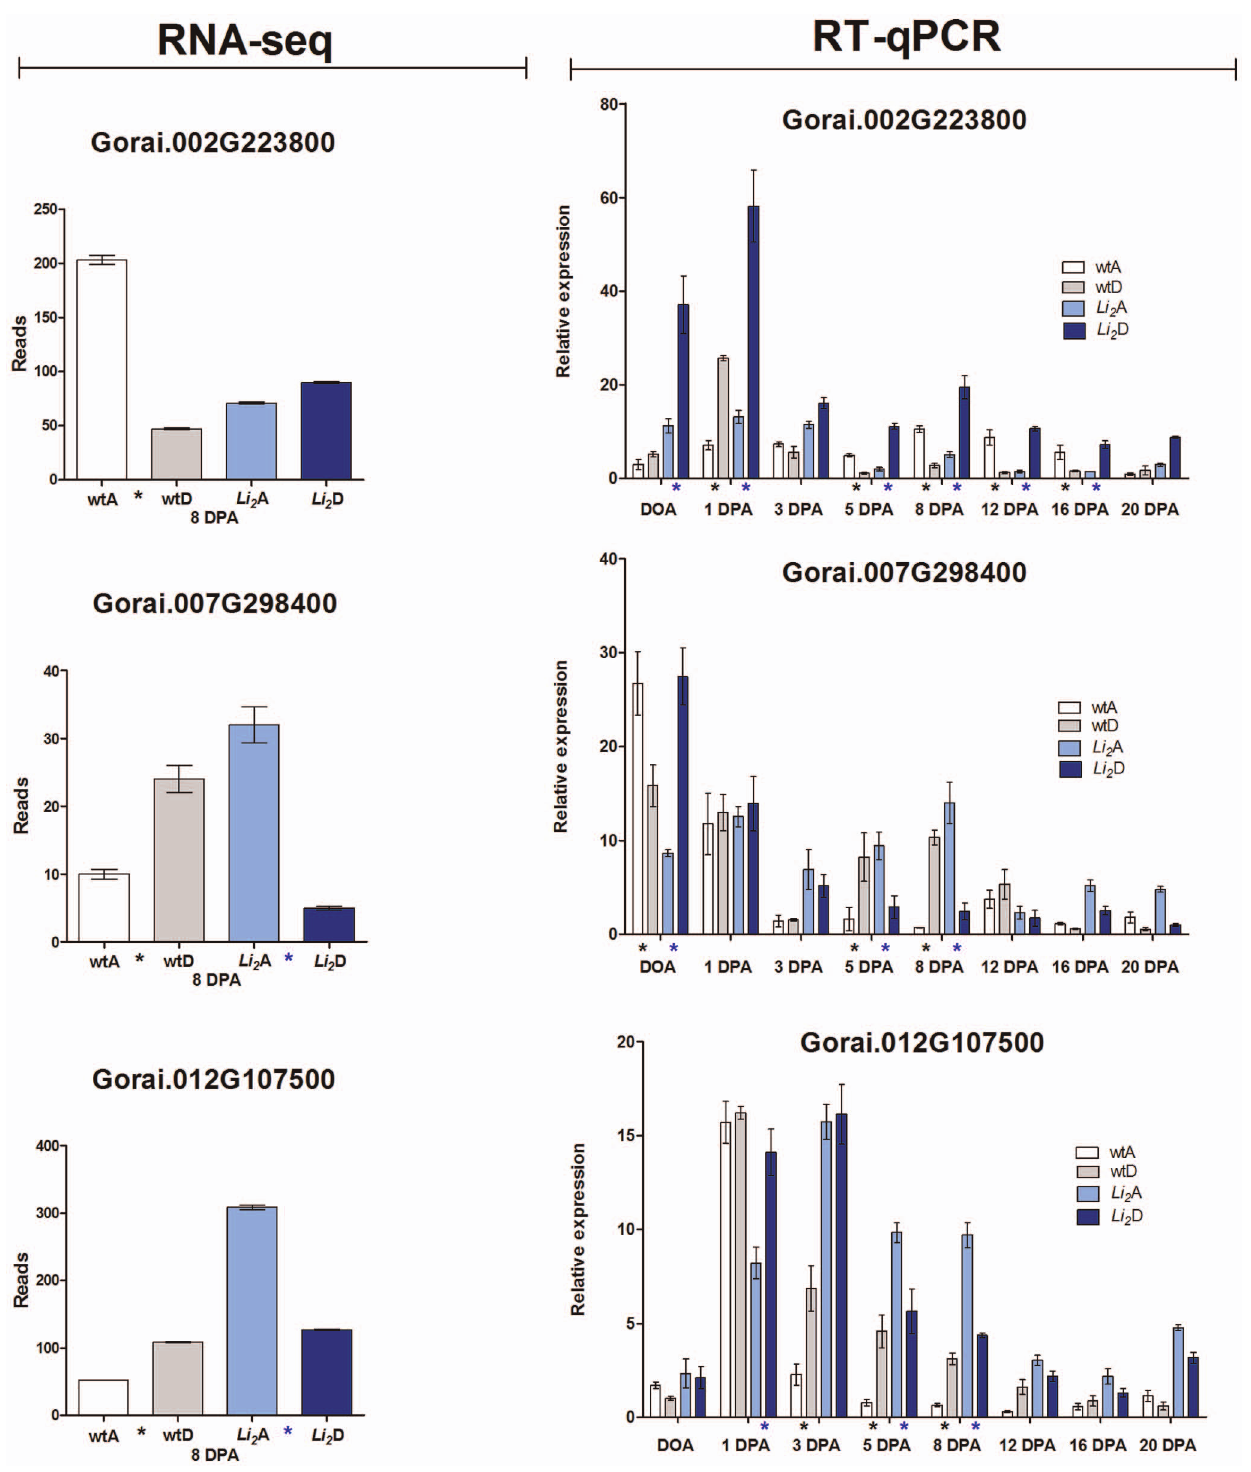
Figure 3. RNA-seq and rt-qPCR analysis detected reciprocal expression biases as a result of mutation. Original RNA-seq data are shown on left. Asterisks indicate significant ( p -value , 0.05) difference in gene expression level between A T vs. D T subgenomes in wild type (black) and mutant (blue) developing fibers. Error bars represent standard deviation from two biological replicates for RNA-seq data and three biological replicates for RT-qPCR.